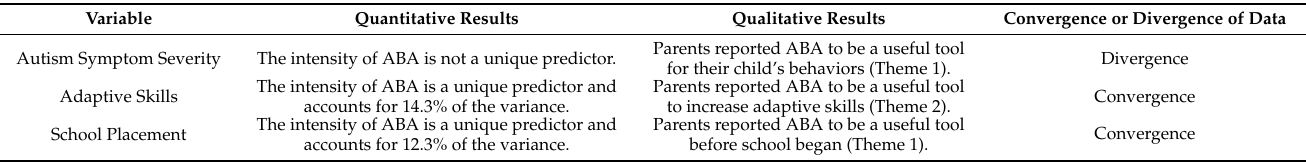
Table 8. Comparison and Integration of Findings from Quantitative Analyses with the Comparable Qualitative